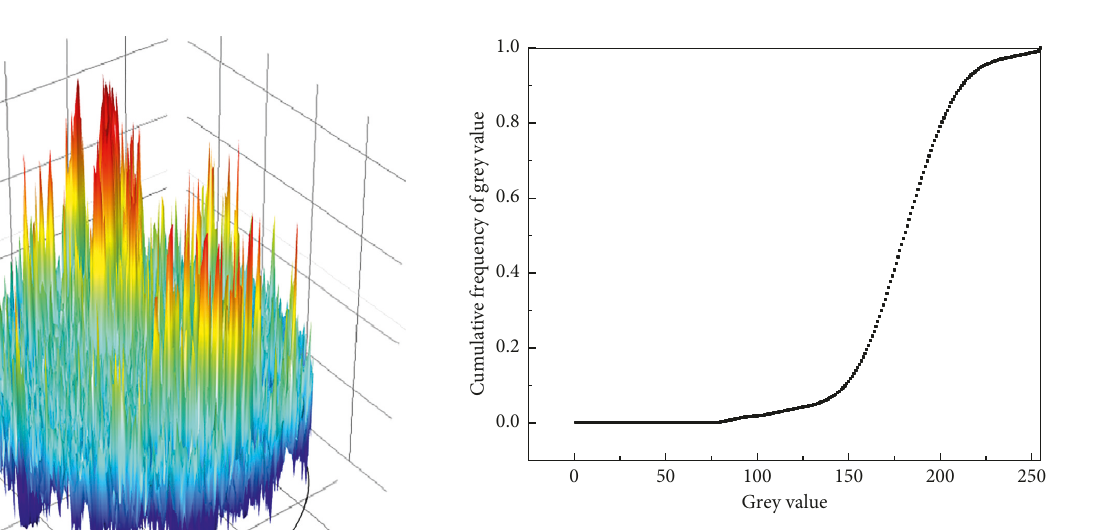
Figure 7: CTimage cumulative greyscale value frequency